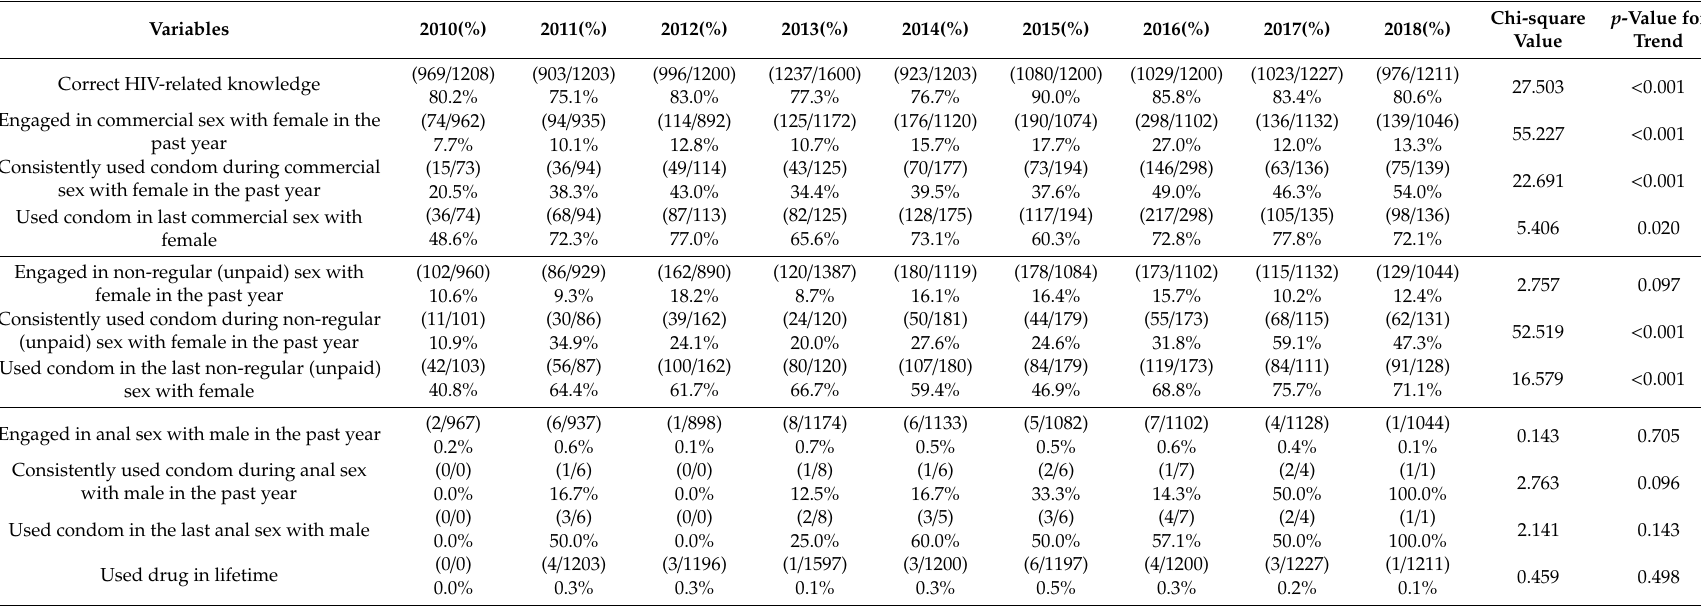
Table 2. HIV-related knowledge and behaviors among MMWs between 2010 and 2018 in